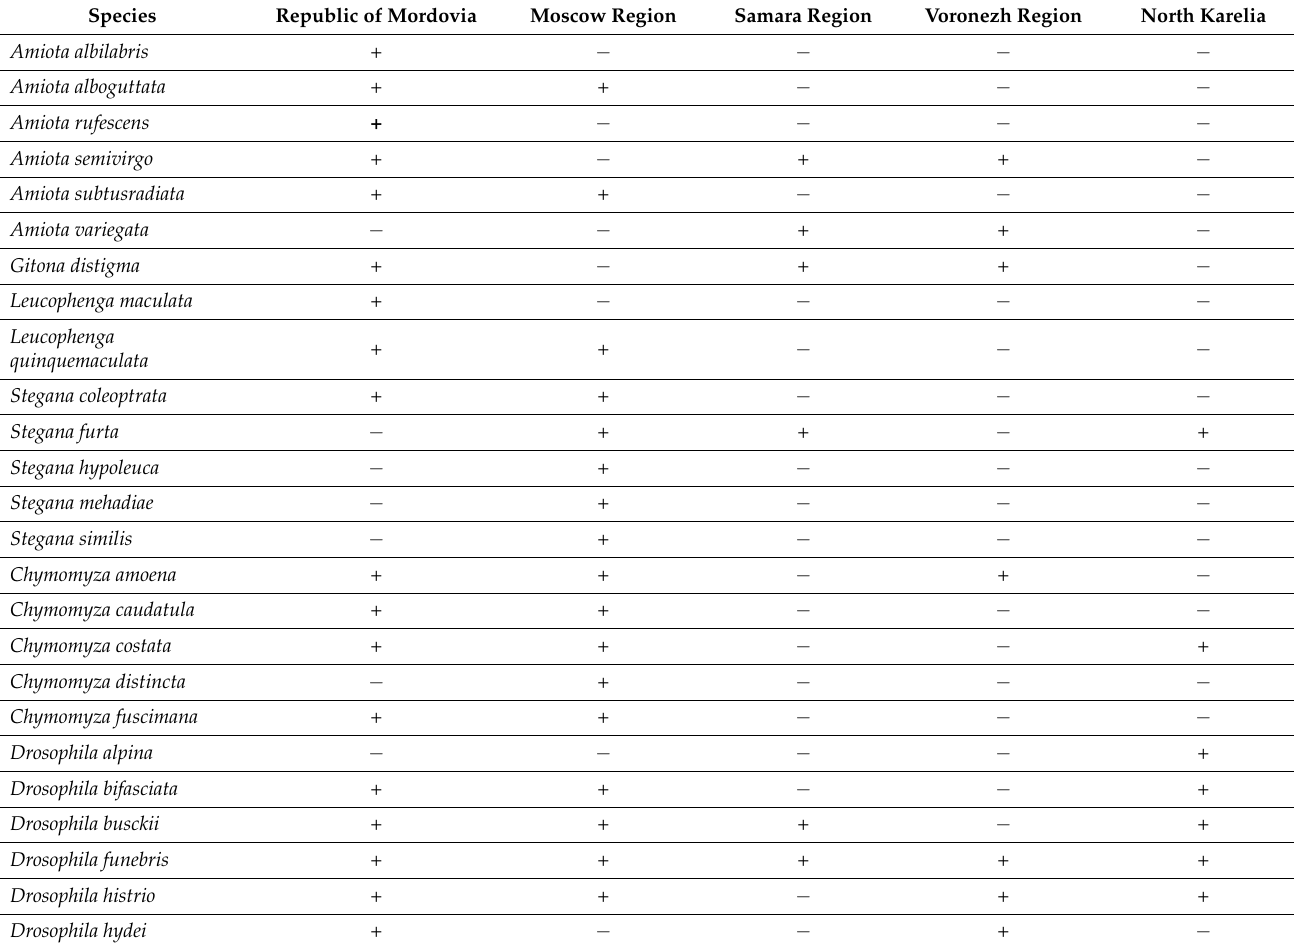
Table 6. Comparison of drosophilid fauna in five regions of European